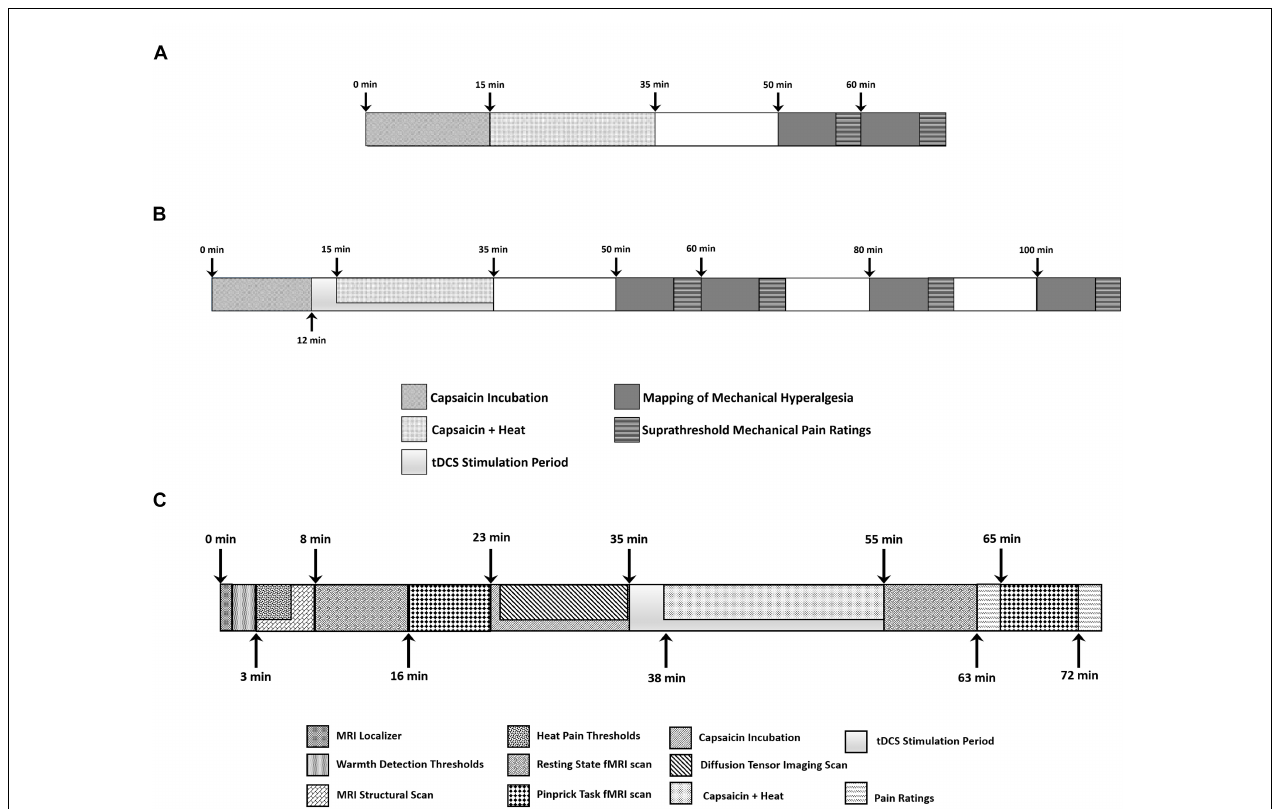
FIGURE 2 | Timeline of events during (A) screening session and (B) each experimental session where subjects experienced anodal, cathodal or sham tDCS. (C) Each subject underwent three MRI scanning sessions where they experienced anodal, cathodal or sham